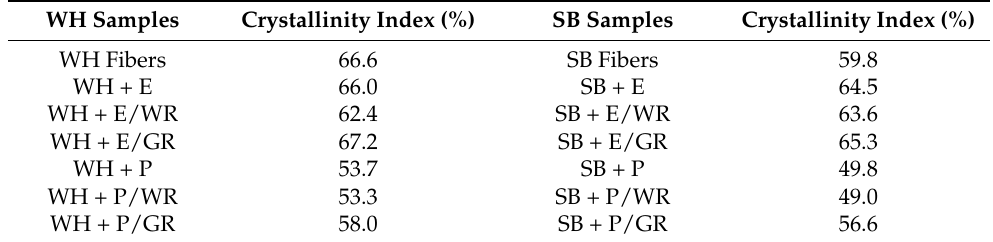
Table 3. Crystallinity Index (%) of WH and SB fiber and composite samples before and after surface